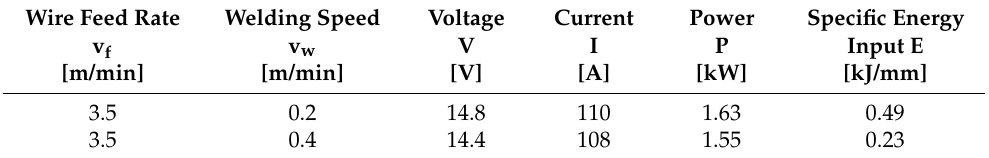
Table 2. WAAM welding parameters. Standard welding speed is 0.4 m/min, the variation of the welding speed is only realized for the fifth (last) layer.